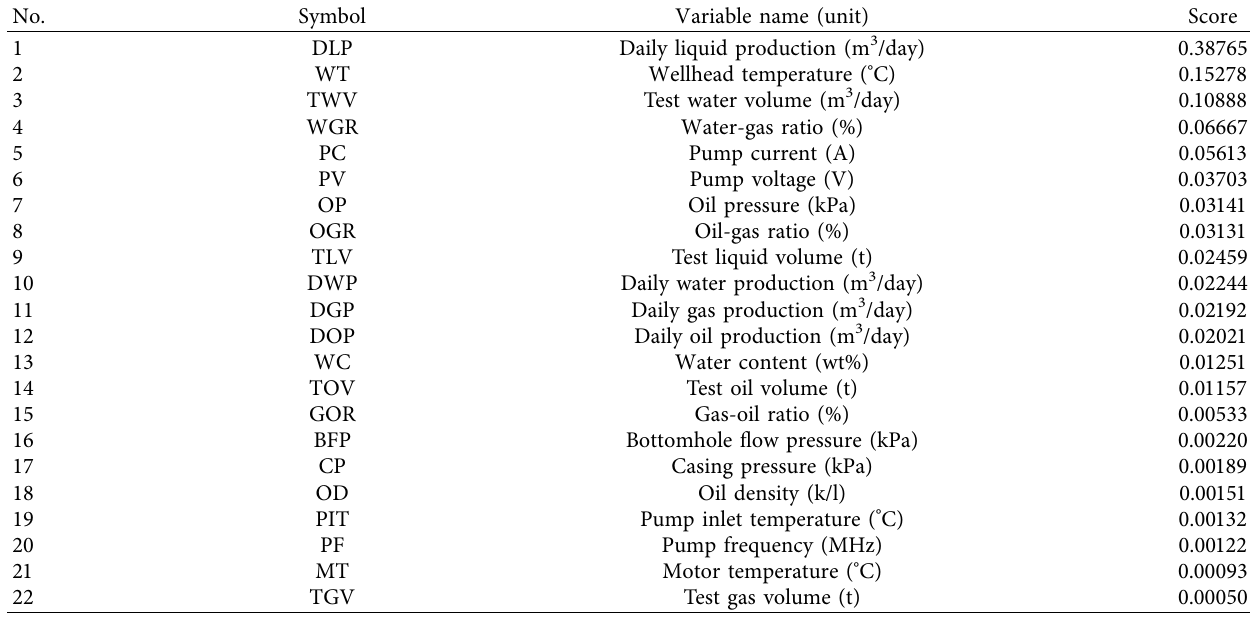
Table 2: Description of the variables of the